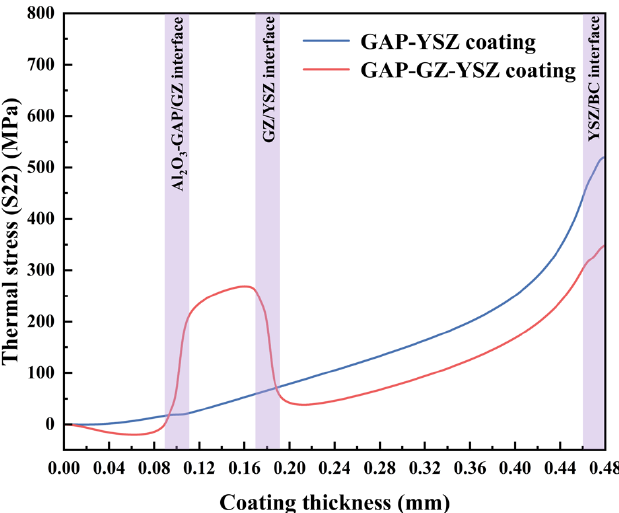
Figure 13. Thermal stress (S22) distribution along coating thickness in TBC system with two kinds of TC design after quenching.